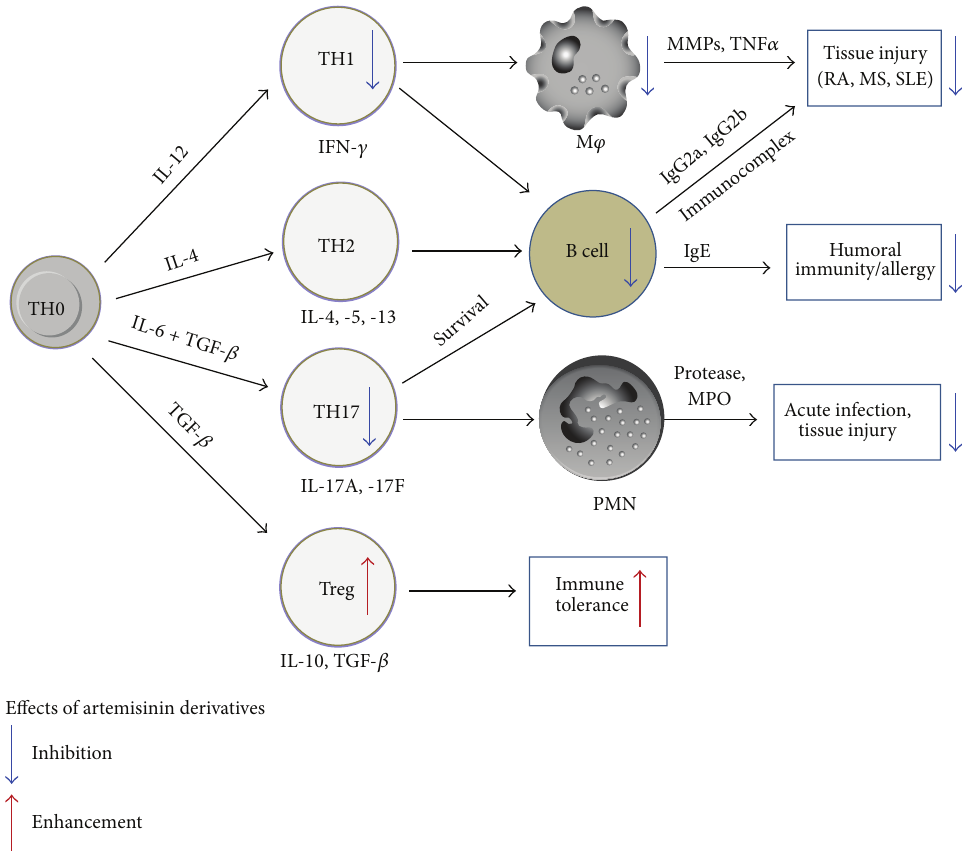
Figure 2: Schematic of artemisinin derivatives affecting immune and